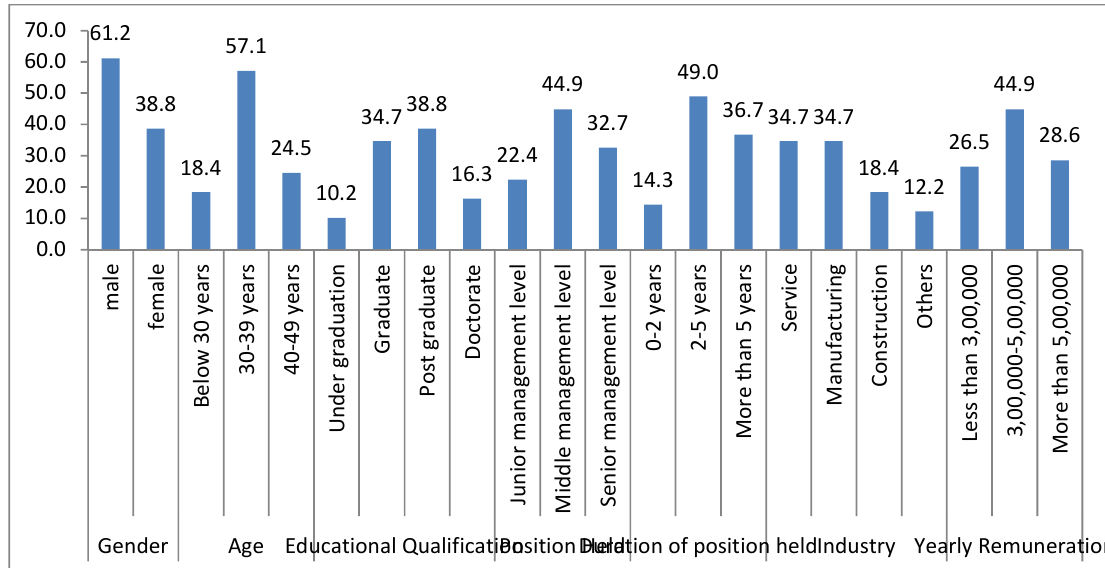
Fig. 2. Frequency distribution of demographic